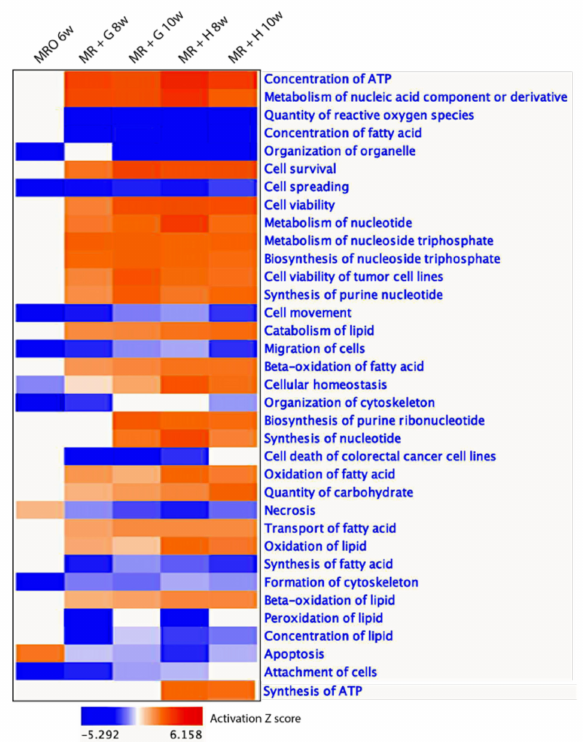
Figure 7. Comparison analysis-cellular function: Functional analysis of differentially expressed genes during the transition from pre-rumination to rumination in rumen